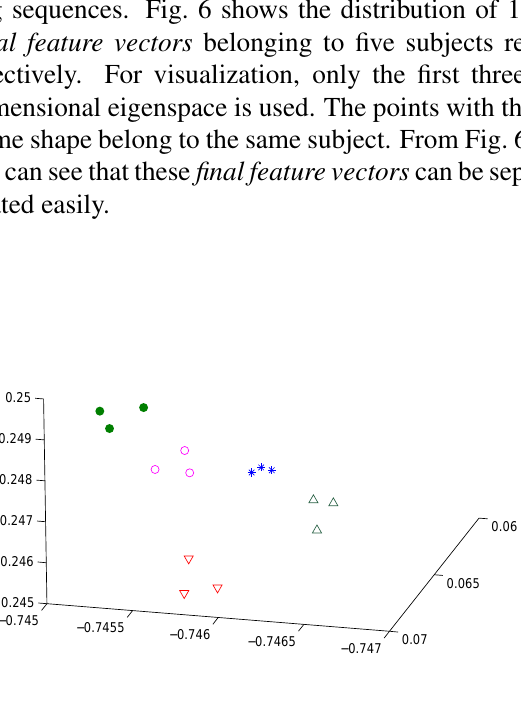
Fig. 7. Cumulative match score of the four